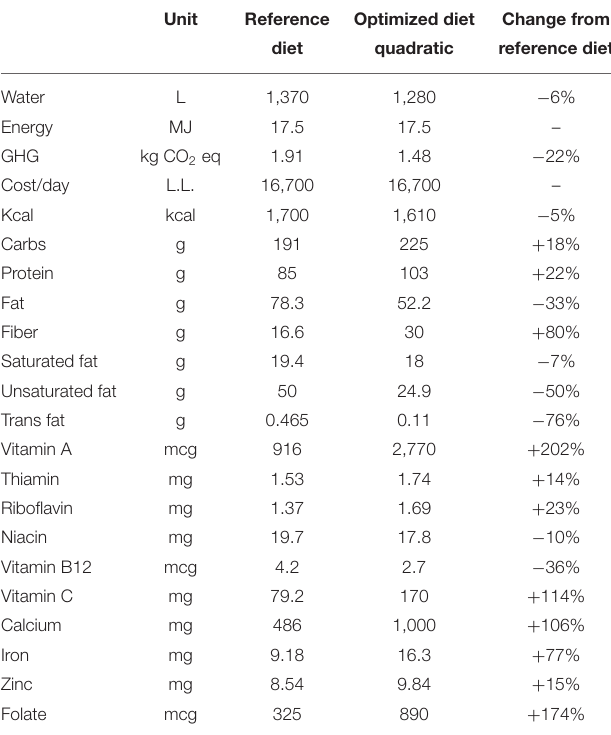
TABLE 6 | Daily values of EFPs, cost, energy, and nutrients from the daily recommended amounts of foods as per the optimized diet. Unit Reference Optimized